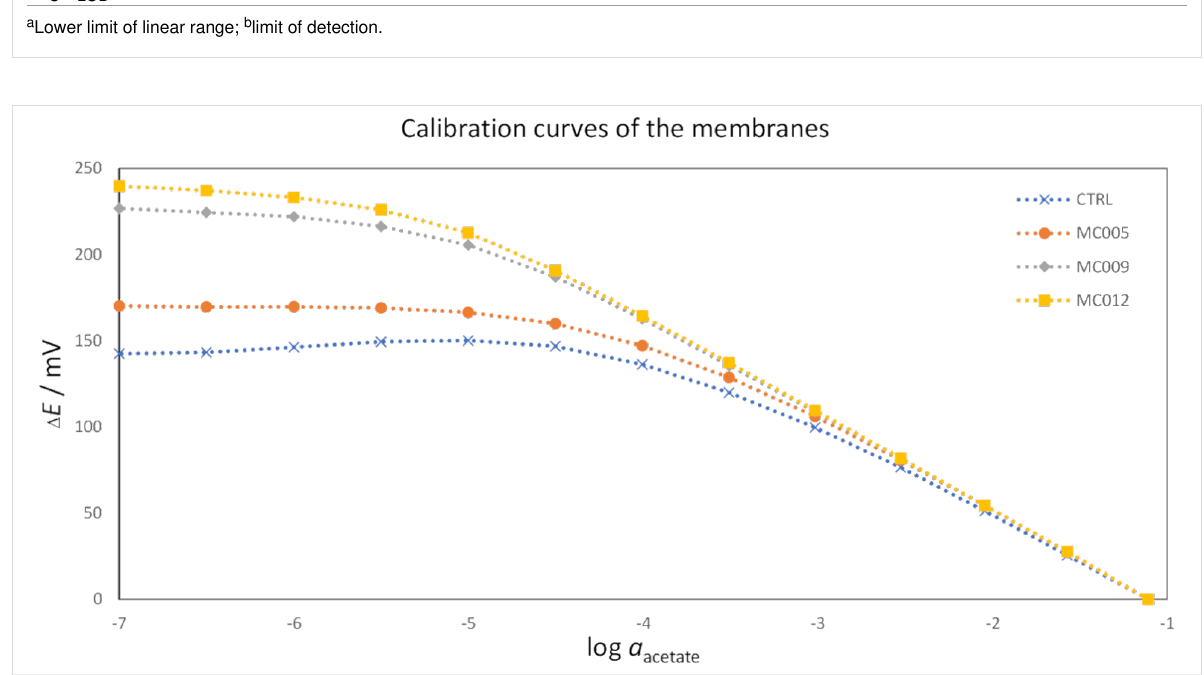
Figure 8: Calibration curves for each of the membranes. The calibrations were performed by diluting 0.1 M sodium acetate in half-decade steps until the potentials of the sensors levelled out. The potentials were shifted along the y -axis to start at Δ E = 0.00 mV at log a = − 1.11.